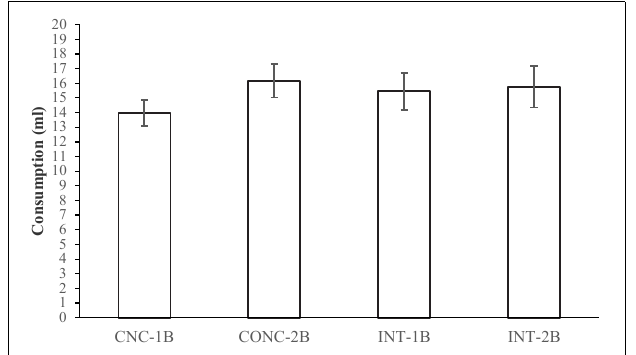
FIGURE 7 | Consumption (ml, mean ± SEM) of the BX solution during the test for the four groups of Experiment